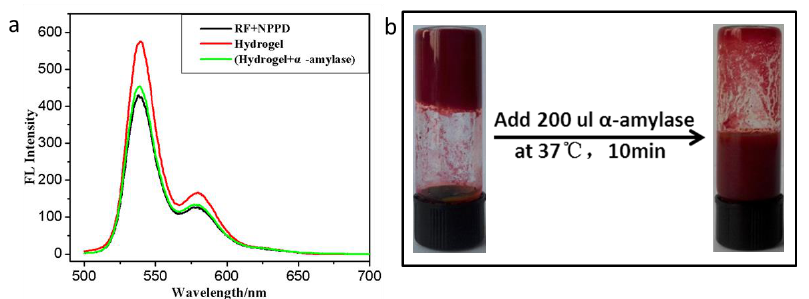
Figure 4. ( a ) The fluorescence spectrum of the hydrogel and two-component solution at room temperature ([NPPD] = 1.0 × 10 −6 mol/L, [RF] = 2 × 10 −6 mol/L, [α-CD] = 1.0 × 10 −6 mol/L, [α-amylase] = 0.001 mol/L). ( b ) The optical images show the gel hydrolyzed by α-amylase.